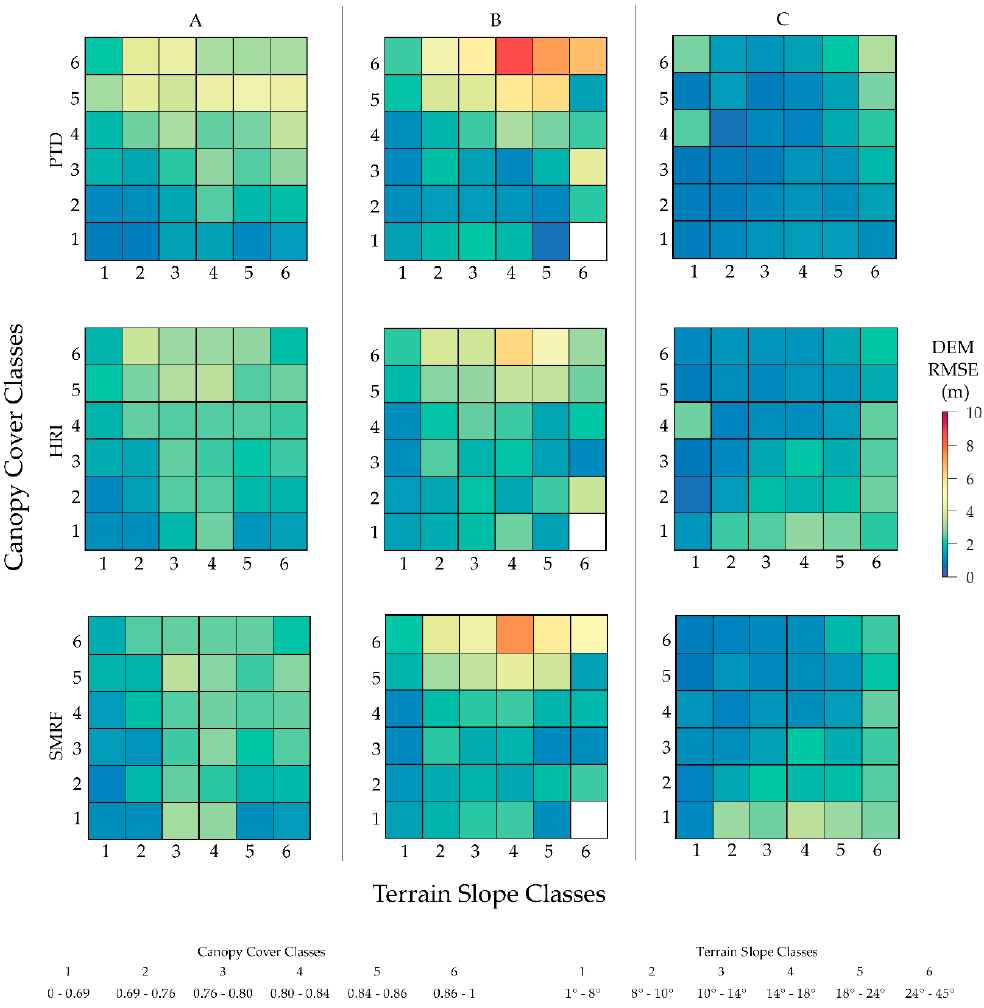
Figure 8. DEM RMSE vs. stratified classes of terrain slope and canopy cover for the three study areas (A, B and C) and ground classification algorithms tested (PTD, HRI and SMRF) and their respective optimal parameterizations found in Section 3.1. The strata combining terrain slope class 6 and canopy cover class 1 was not represented in area B an is denoted by the white square.